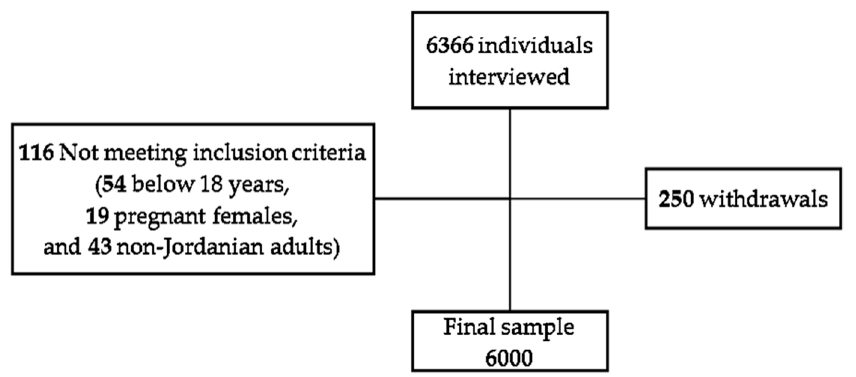
Figure 1. Flow diagram for participant recruitment and procedures for cross-sectional study assessing obesity measures as predictors of type 2 diabetes (T2D) and cardiovascular diseases (CVD) among Jordanian adults.